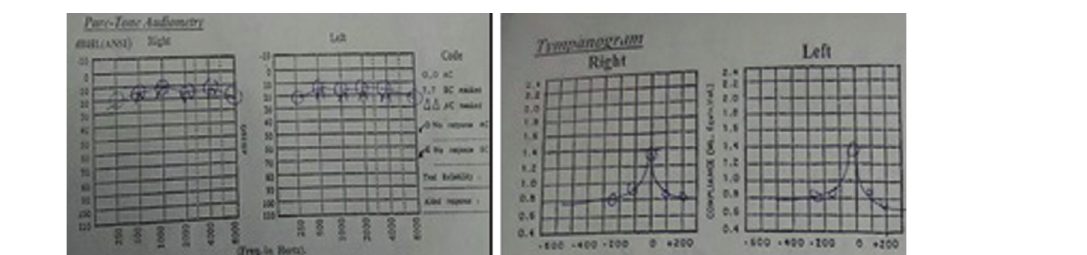
Pure-tone audiometry and